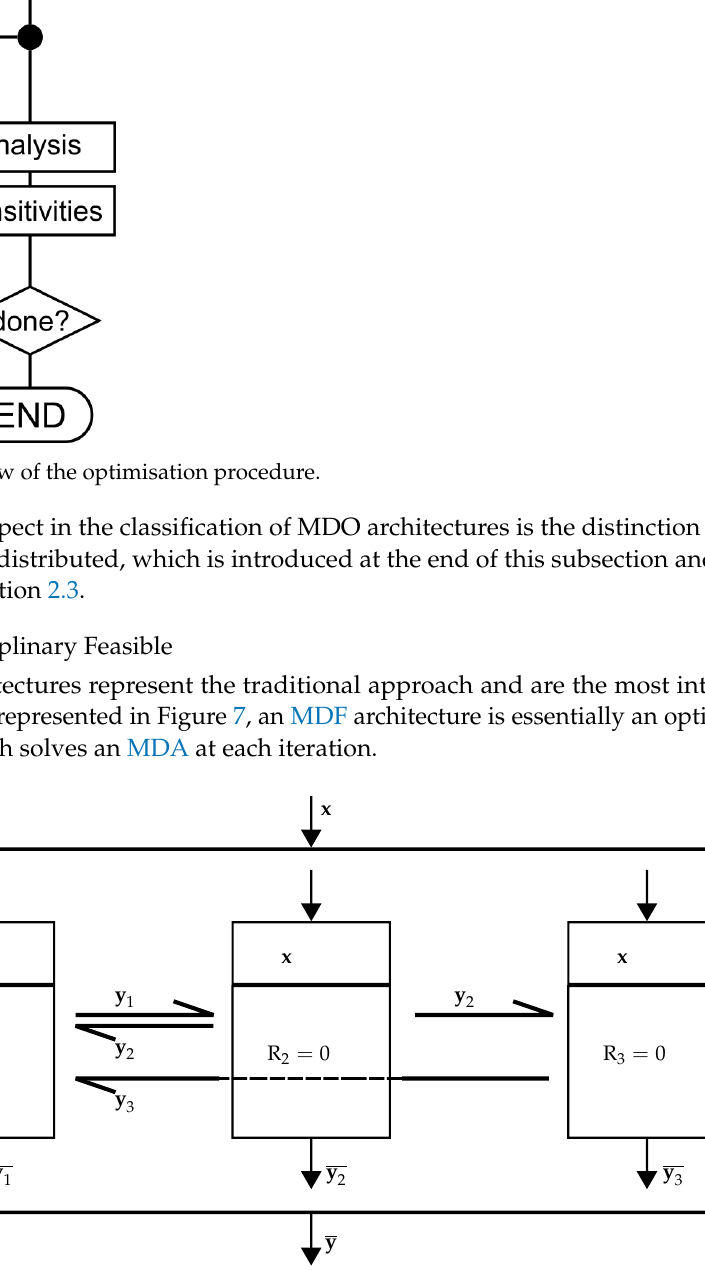
Figure 7. Flowchart of multidisciplinary feasible architecture: detail of the analysis block from Figure